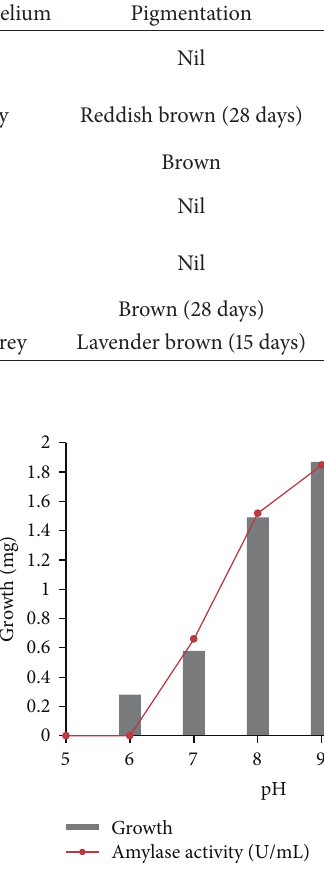
Figure 4: Growth and Amylase activity of BTSS 1001 at various incubation periods.